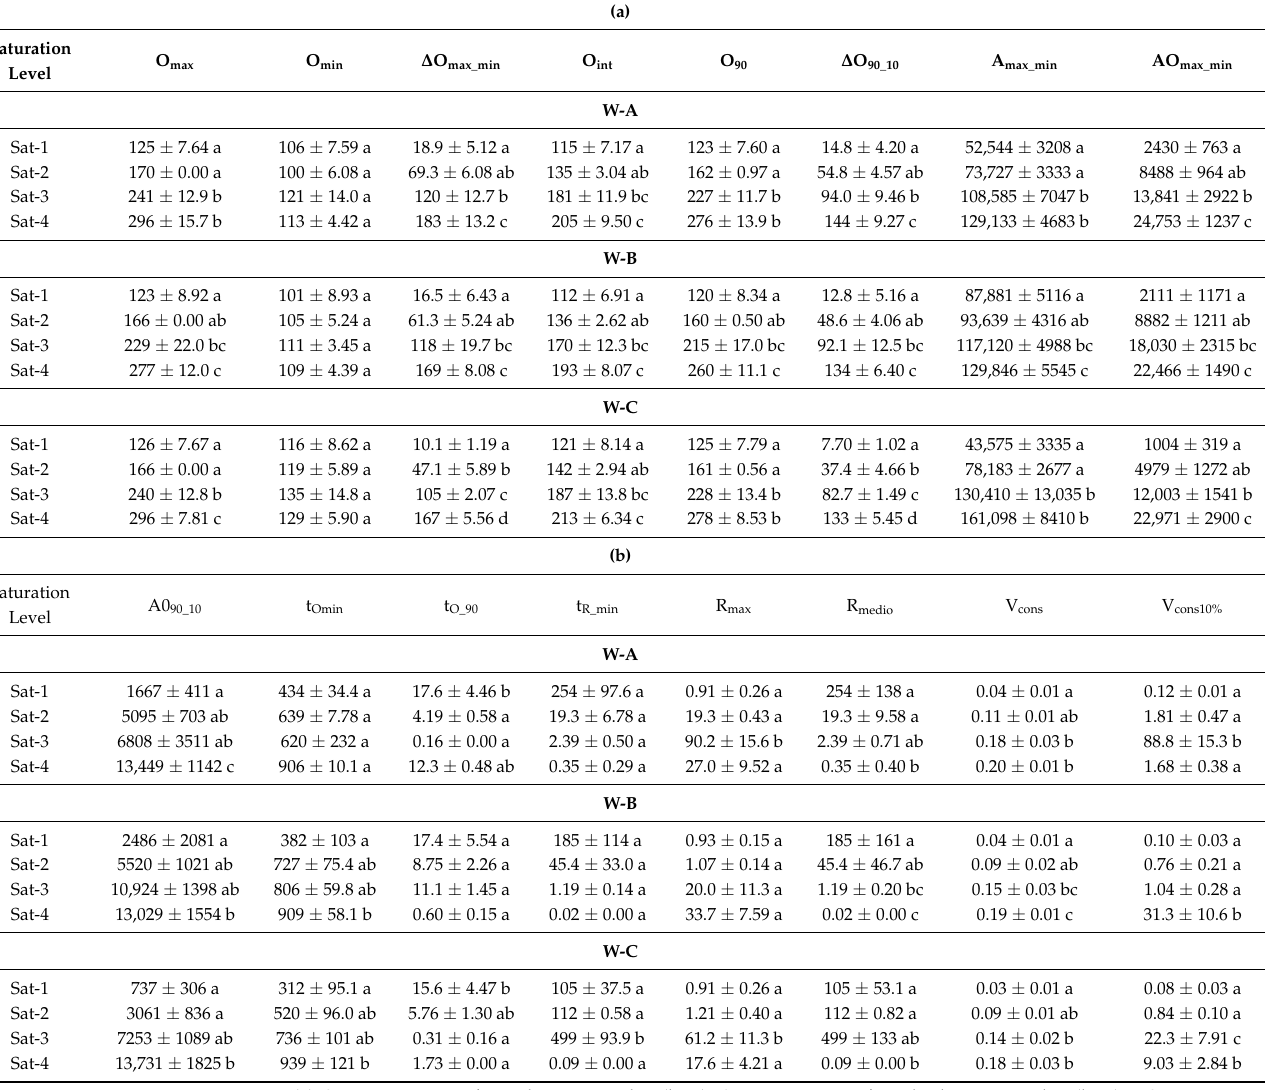
Table 1. ( a ) W-A, W-B, and W-C parameters at the four oxygen saturation levels (Sat-1, Sat-2, Sat-3, and Sat-4). ( b ) W-A, W-B, and W-C parameters at the four oxygen saturation levels (Sat-1, Sat-2, Sat-3, and